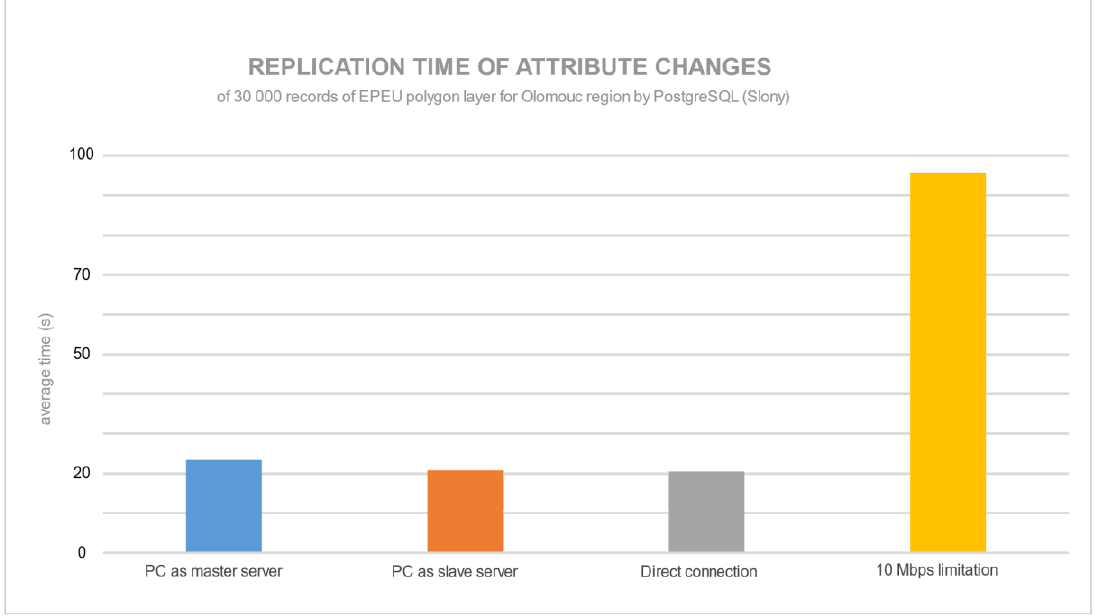
Figure 16. Average replication time of layers with different cluster configurations by MySQL.